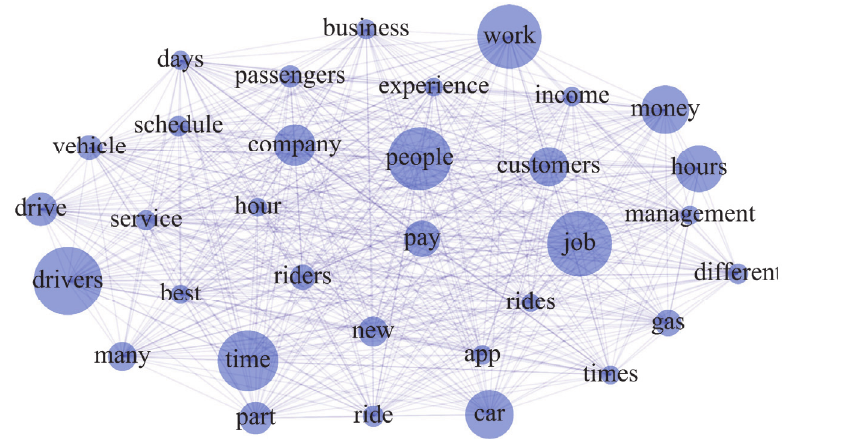
Fig. 6. Most Commonly Used Words Drivers’